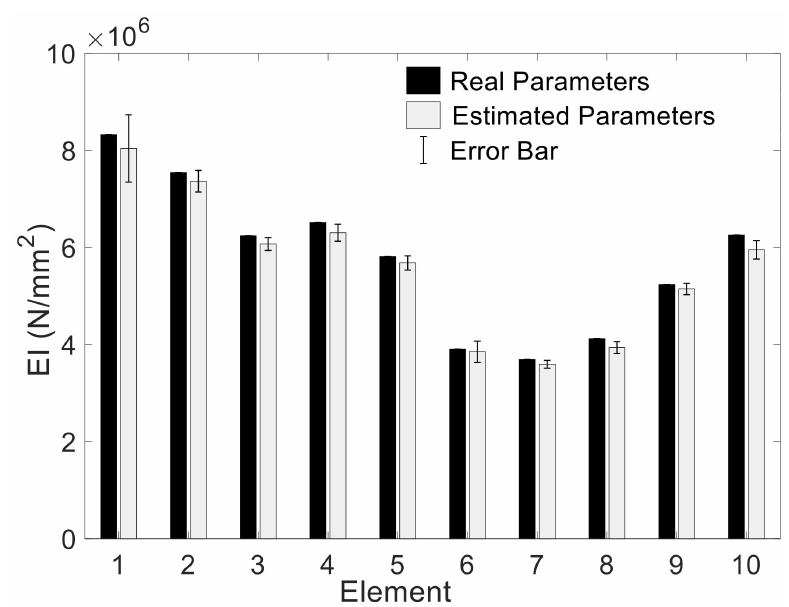
Figure 14. Uncertainty of EI i , i = 1 ∼ 10 given by the mean value and the standard